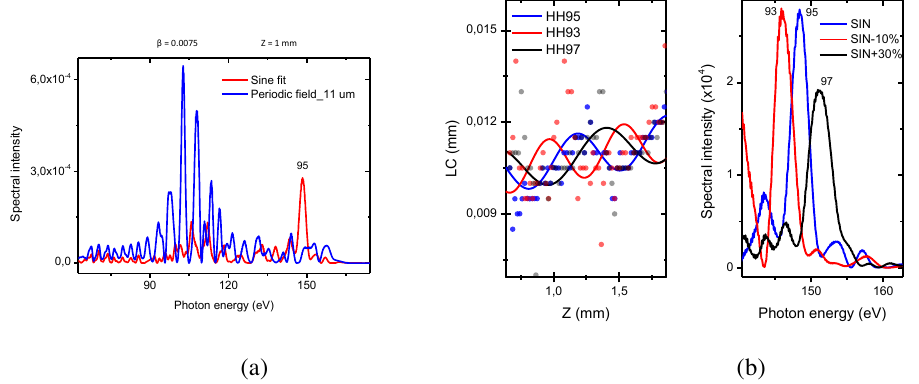
Fig. 4. (a) Specific enhancement of the harmonic 95 obtained by using a sine fit. (b) Tuning of the enhanced harmonic by fine-adjusting the period of the sine